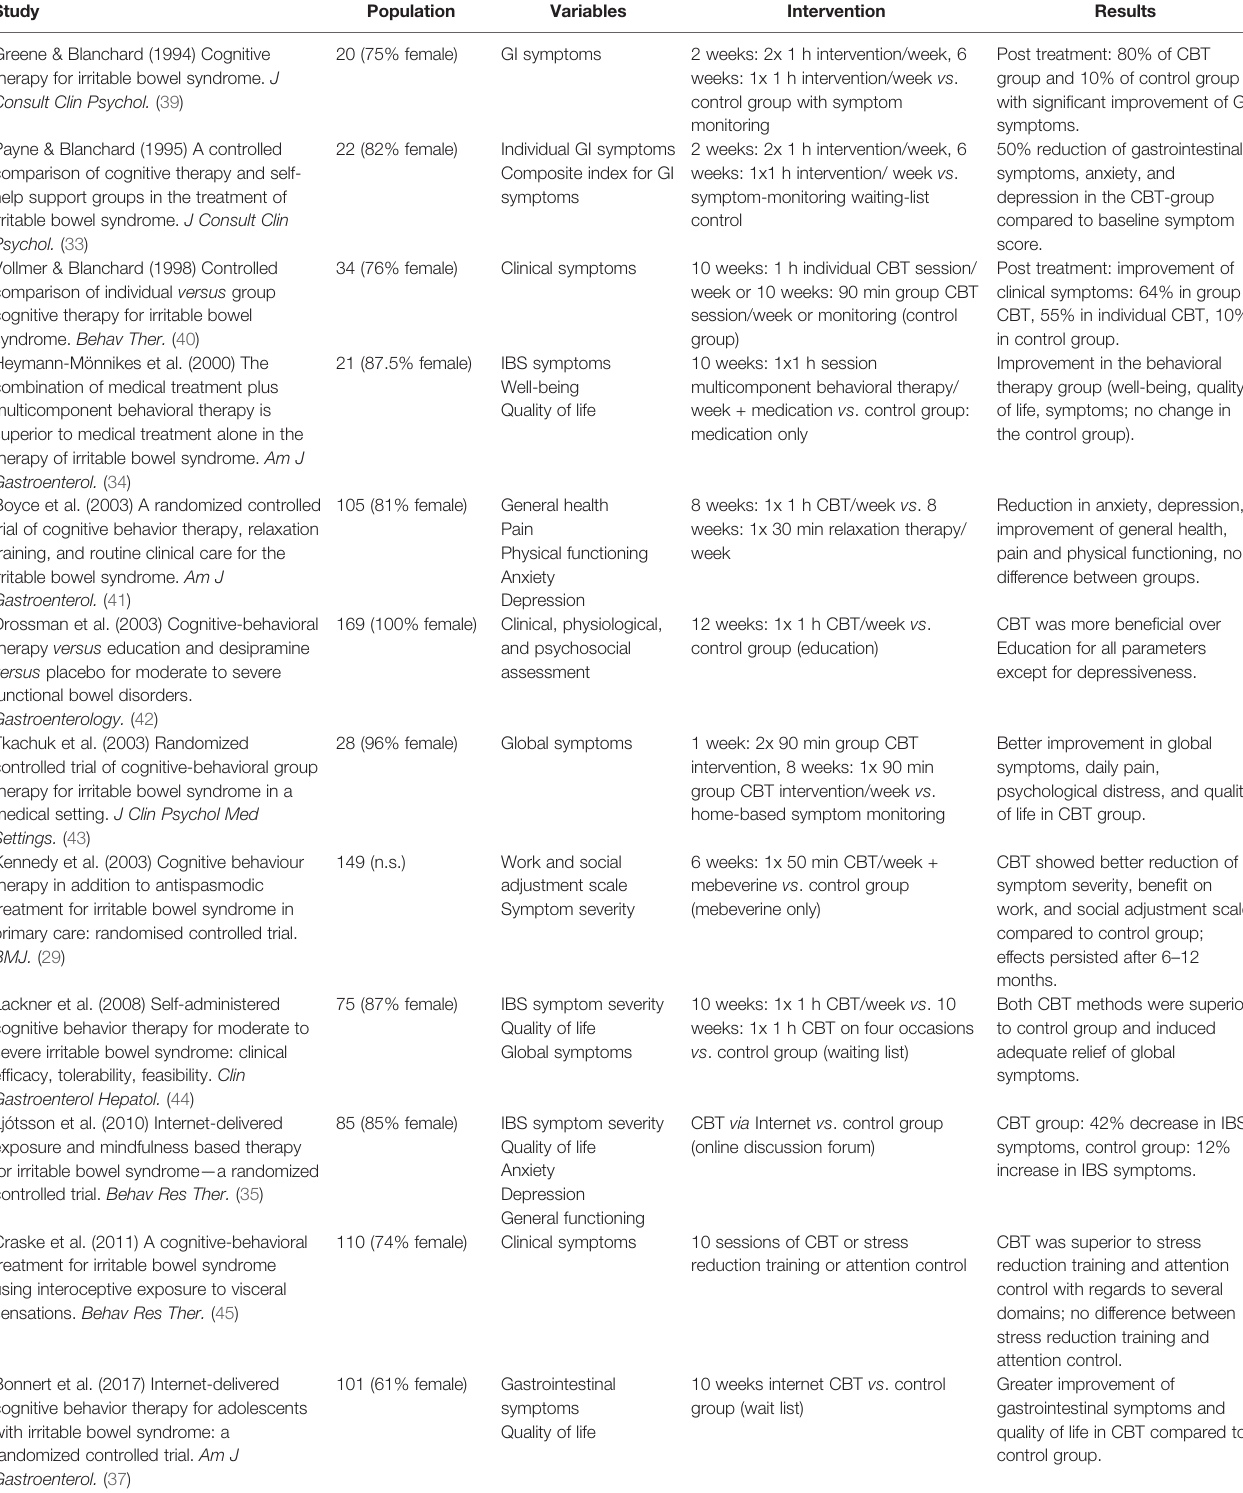
TABLE 3 | Randomized controlled studies investigating the effects of cognitive behavioral therapy in patients with irritable bowel syndrome. Study Population Variables Intervention Results Greene & Blanchard (1994) Cognitive therapy for irritable bowel syndrome. J Consult Clin Psychol. (39) control group with symptom